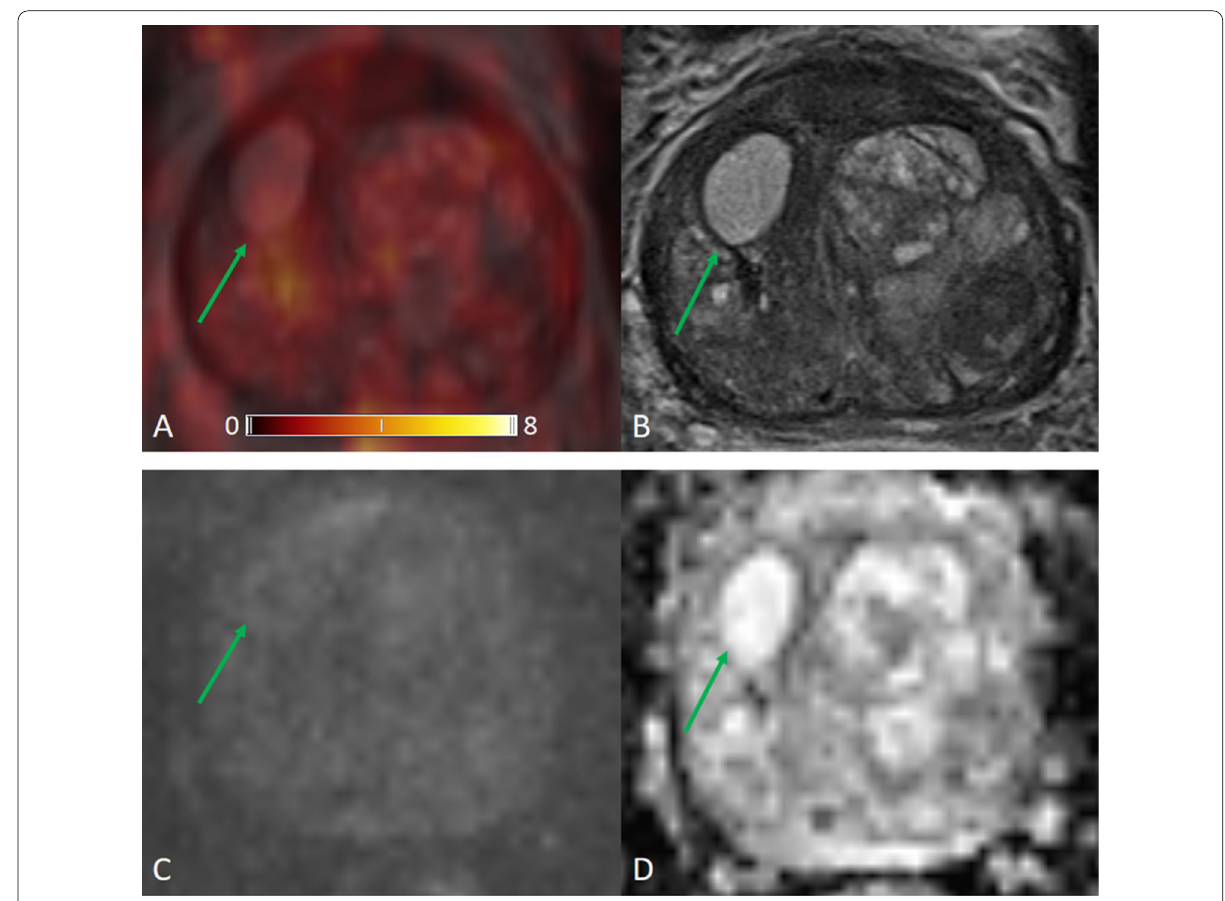
Fig. 5 [ 68 Ga]Ga-PSMA PET/MRI images obtained in a 72-year-old man, PSA 24.81 ng/mL. a [ 68 Ga]Ga-PSMA PET/MRI; b T2WI; c DWI, b value 1000 s/mm 2 ; d ADC. This example showed an MRI-negative lesions, a typical encapsulated nodule with unapparent radiotracer uptake in [ 68 Ga] Ga-PSMA-11 PET. SUVmax 1.9, right TZ, background SUVmax 1.2, LBR